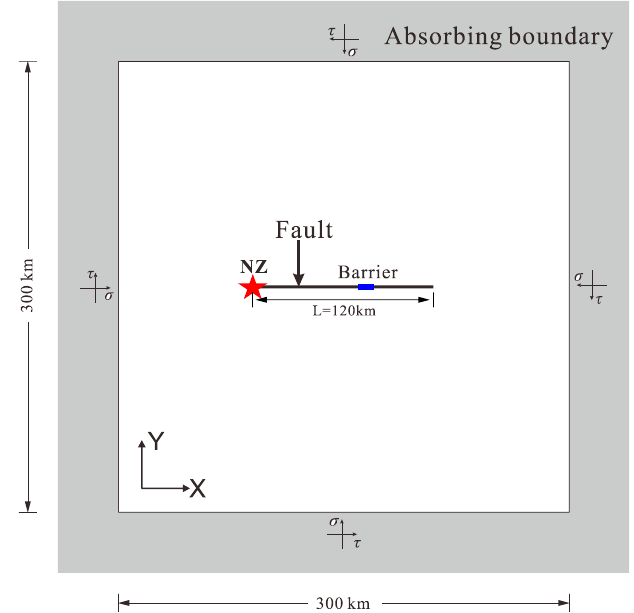
Figure 1. Model geometry, the initial conditions, and boundary conditions. The model domain is 300 by 300 km. The black line in the figure represents the location of the fault, and the red star marks the nucleation patch. The blue line denotes the barrier, and the gray region around the model is the absorbing boundary.